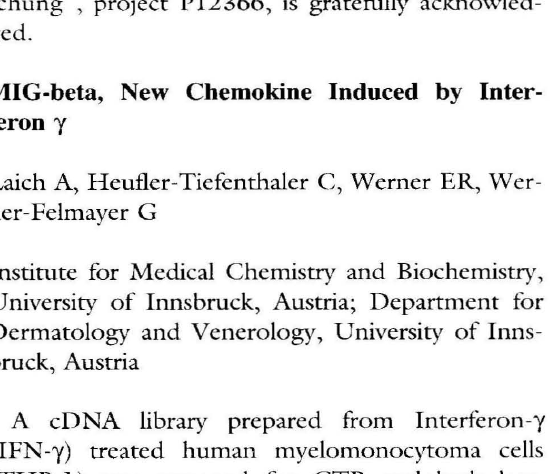
Figure 1. Type I spectrum of camphor with cytochrome P450cam.